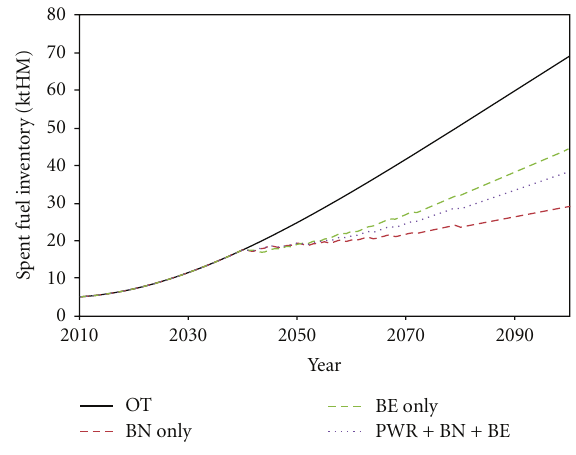
Figure 8: Spent fuel inventory.